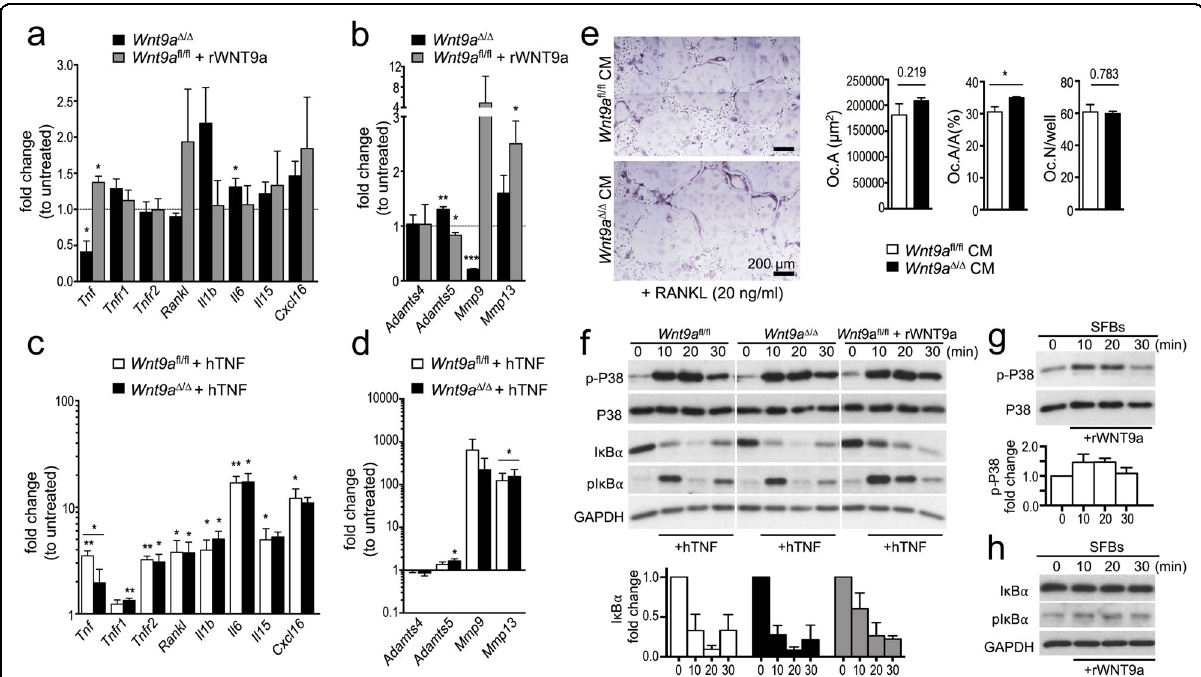
Fig. 4 Molecular consequences in synovial fi broblasts after Wnt9a deletion or exogenous stimulation with WNT9a or TNF. a – d qPCR analysis of proin fl ammatory cytokines, TNF receptors 1 and 2, and Rankl in Wnt9a -de fi cient and wild-type (Wnt9a fl / fl ) SFBs ( a , c ), and of catabolic enzymes involved in cartilage degradation ( b , d ) stimulated with rWNT9a for 5 days ( a , b ) or treated with hTNF for 48 h ( c , d ). Data are displayed as fold expression changes relative to untreated SFBs ( n = 3). e Images of osteoclast differentiation cultures treated for 4 days with conditioned medium (CM) from control ( Wnt9a fl / fl ) or Wnt9a -de fi cient SFBs in the presence of 20 ng/ml RANKL; quanti fi ed for OC.A (average area covered by a single osteoclast), OC.A/A in % (osteoclast area per total area), and OC.N (osteoclast number per well). f Immunoblot for p-P38, P38, I κ B α , and GAPDH using extracts from Wnt9a fl / fl and Wnt9a Δ / Δ hTNF-treated SFBs, and Wnt9a fl / fl SFBs rWNT9a pretreated (2 h) followed by hTNF treatment for the indicated time; below the quanti fi cation of I κ B α relative to GAPDH levels. g Immunoblot for p-P38 and P38 using extracts from rWNT9a-treated SFBs; below the quanti fi cation of the p-P38 relative to P38 levels. h Immunoblot for I κ B α , pI κ B α , and GAPDH (loading control) using extracts from rWNT9a-treated SFBs. ( a – h ) n = 3. P -values: *<0.05,